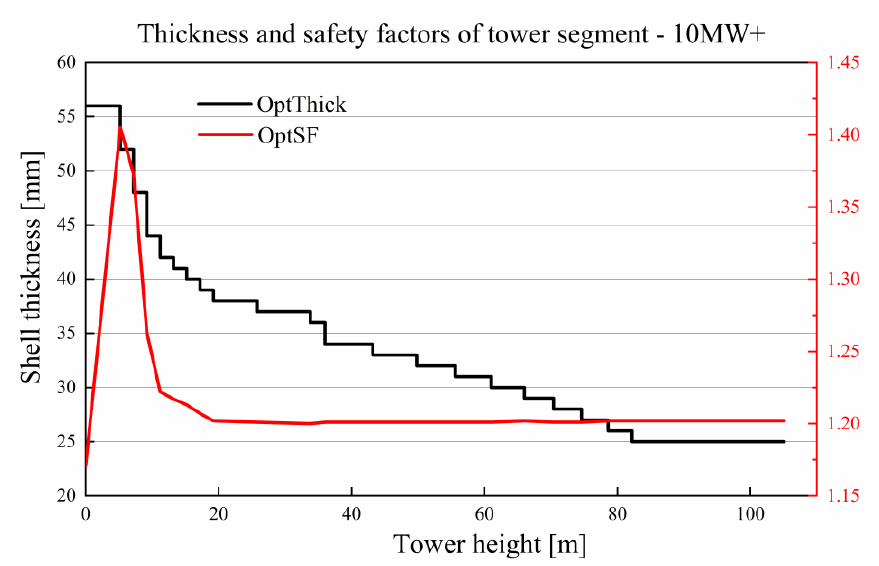
Figure 7. Thickness and safety factors of 10MW+ tower segment.